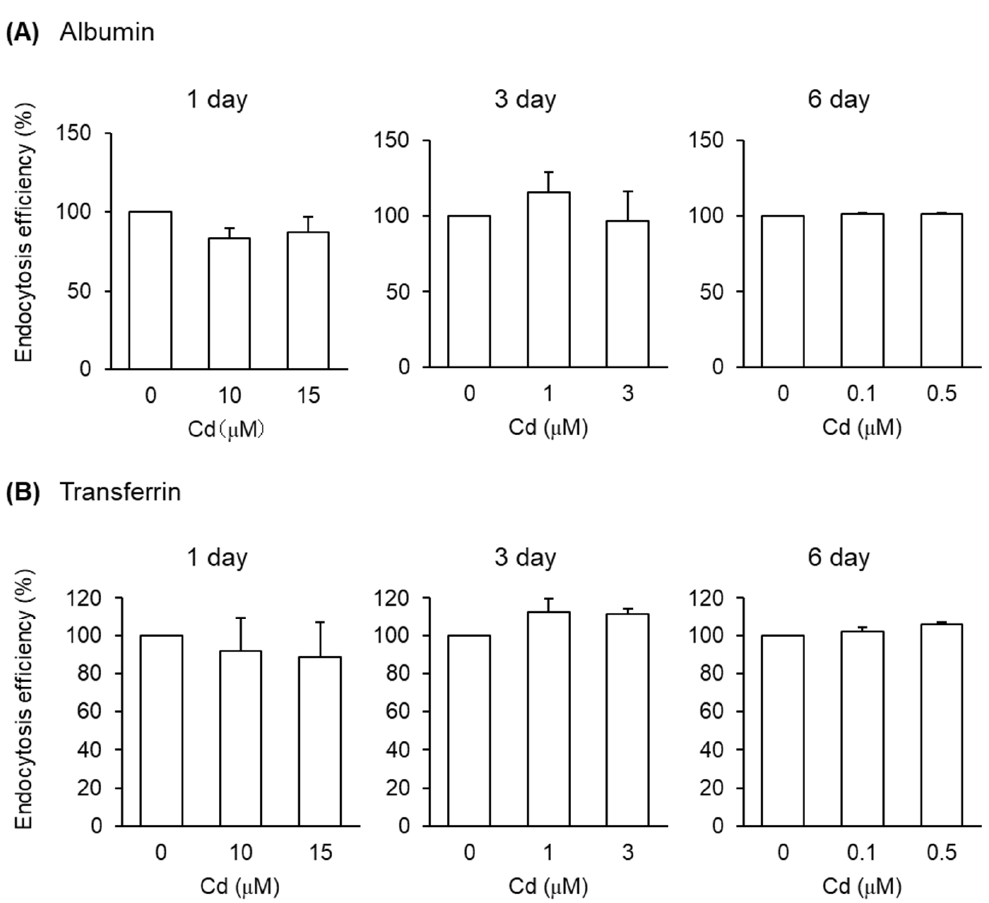
Figure 4. E ff ects of Cd on the endocytosis e ffi ciencies of albumin and transferrin into S1 cells. S1 cells were exposed to CdCl 2 for 1, 3, and 6 days and then incubated with FITC-albumin ( A ) or Alexa-transferrin ( B ) for 30 min. The endocytosis e ffi ciencies were determined by flow cytometry and expressed as percentages of the control cells (no exposure to Cd). Data are presented as means ± SD ( n = 3–4).